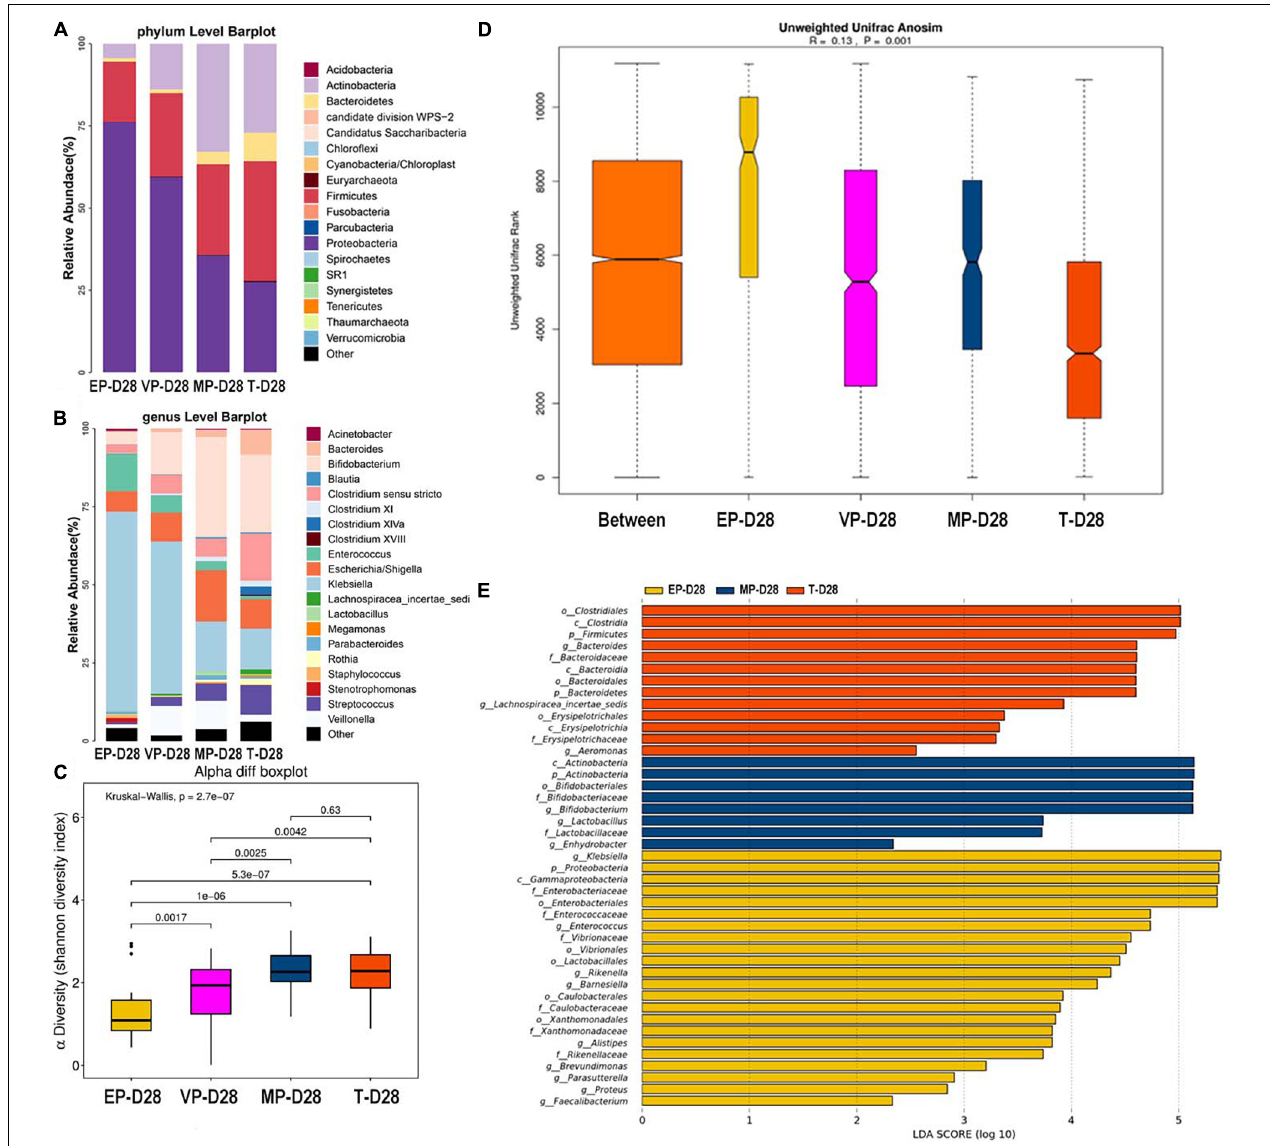
FIGURE 4 | The composition of gut microbiota from neonates with different gestational ages at 28 days after birth. EP, extremely preterm; VP, very preterm; MP, moderate to late preterm; T, full-term. (A) Comparison of abundance at phylum level. (B) Comparison of abundance at genus level. (C) Shannon diversity index of α diversity. (D) Anosim analysis of β diversity. (E) Communities or species that have significantly different effects for each group. The abscissa represents LDA score. LDA score obtained by linear regression analysis of microbial groups with significant effects in different